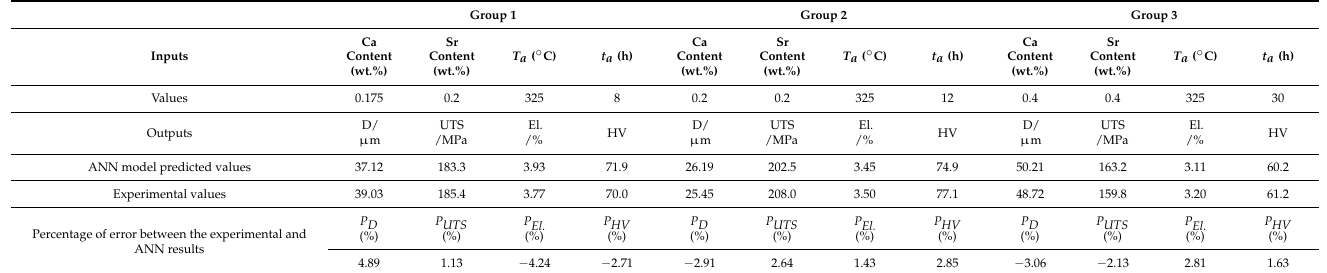
Table 4. Predicted and experimental values of the BP neural network and percentage